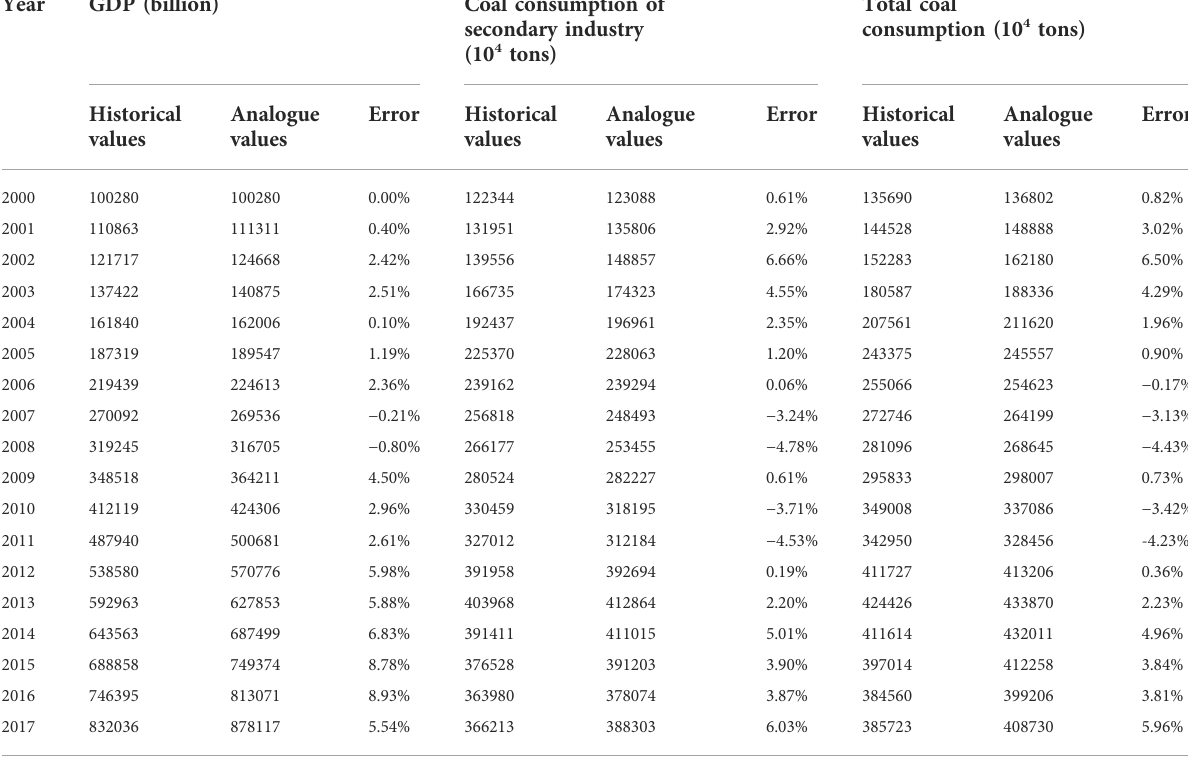
TABLE 11 Test result of historical value and simulated value of model (unit: 10 4